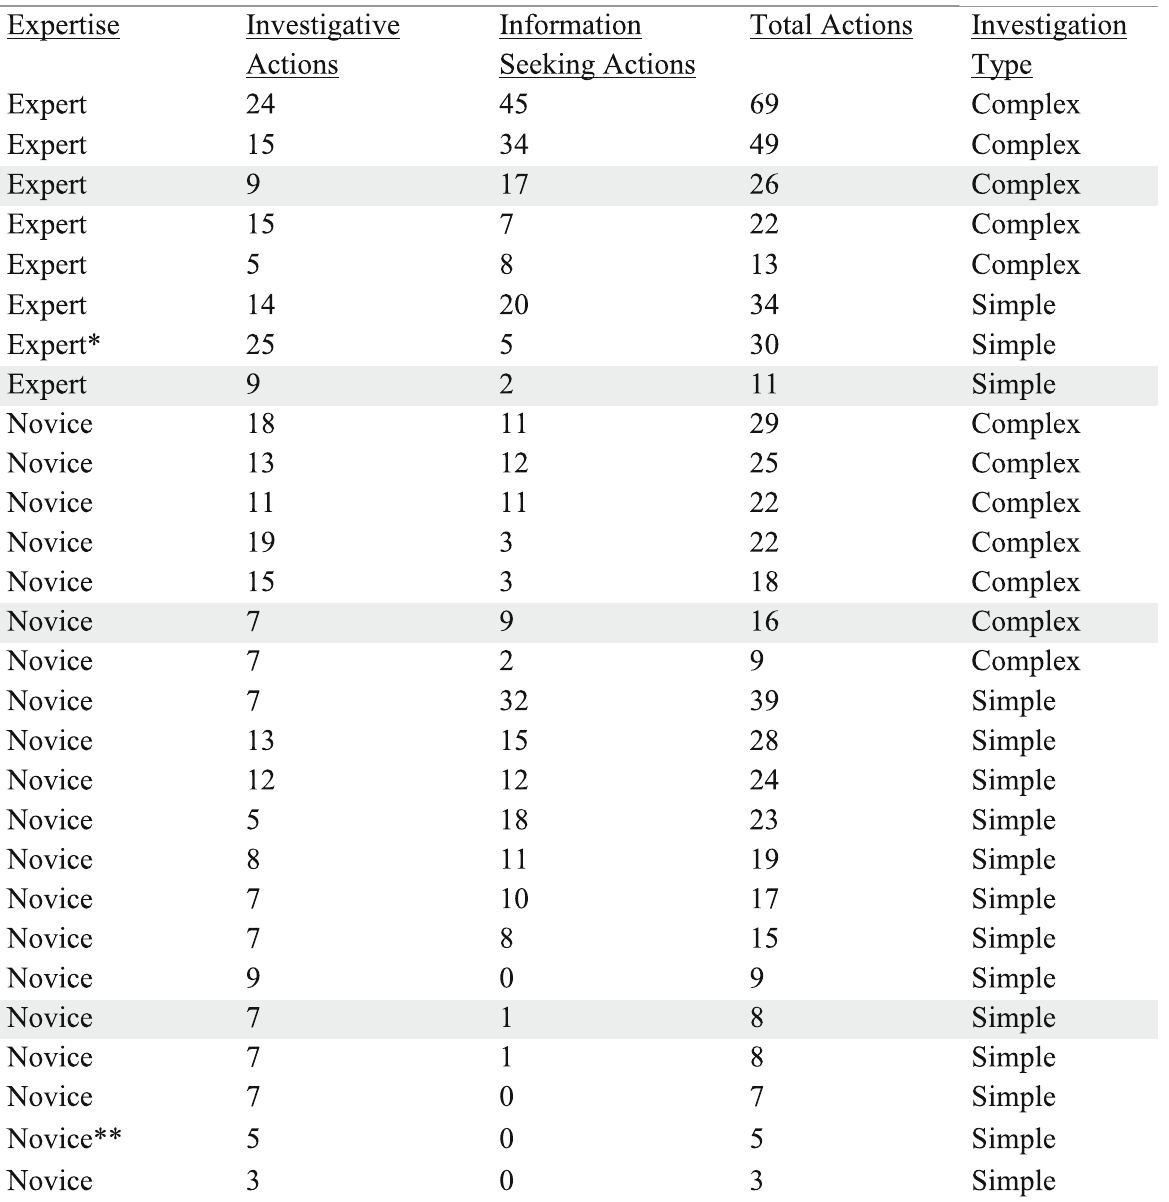
Table 2 Summary of actions performed by all participants